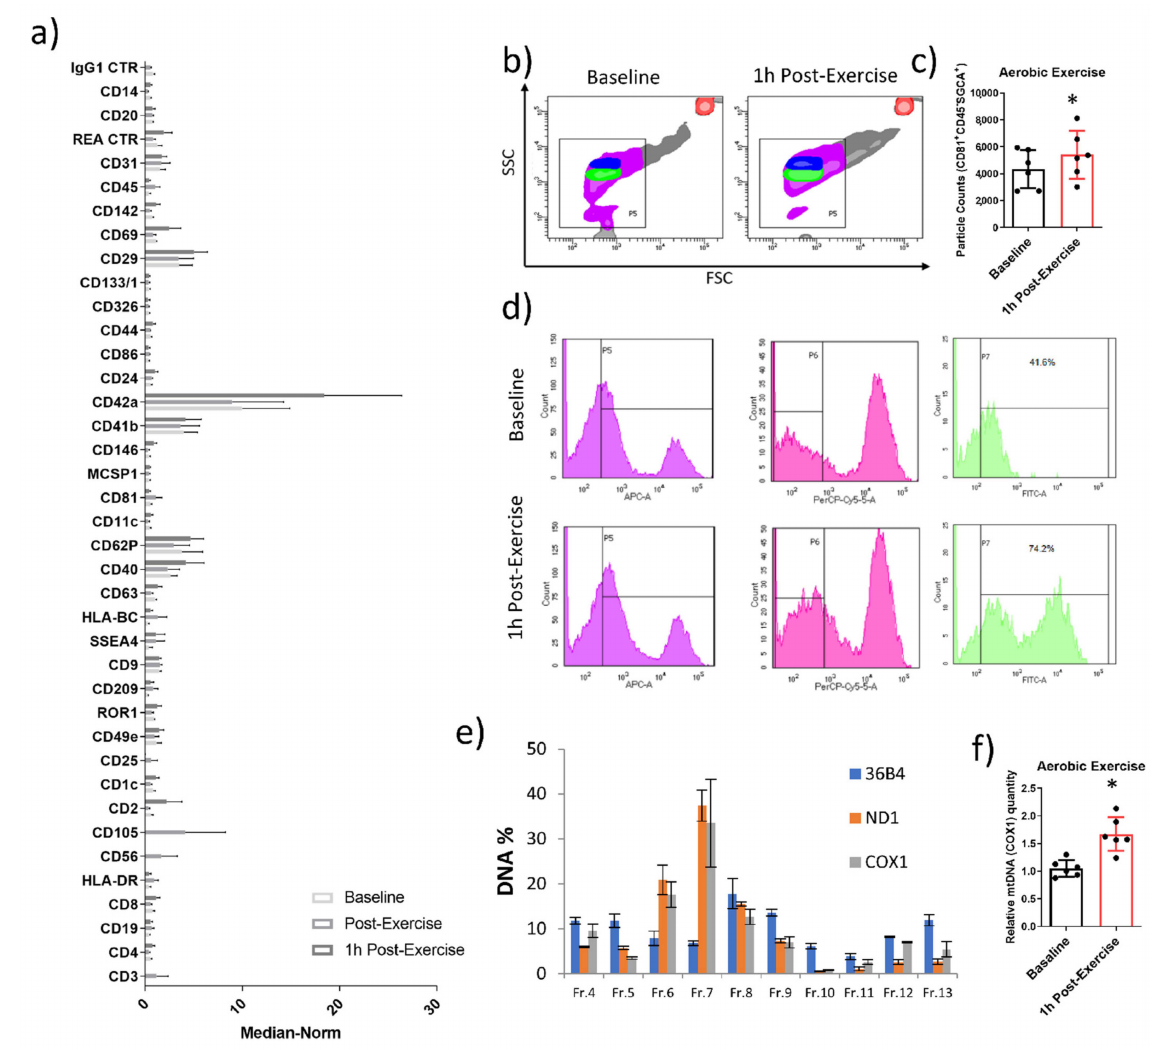
Figure 8. MACS plex analysis for each EV marker of circulating vesicles isolated by SEC (Fr. 7) at baseline and following aerobic exercise (immediately and 1 h after the end of exercise bout) ( a ). Contour plot FSC vs. SSC of EV preparations derived from baseline (left panel) and post-exercise (right panel) samples. Green and blue clusters represent the area of beads sized 500 nm and 1 micron, respectively. Such beads were acquired previously and dispersed in the filtered buffer in which each sample is prepared (see Supplementary Materials Figure S2). The red circle represents counting beads (DakoCyto-Count), whereas pink and violet events represent the EVs further characterised for CDs expression ( b ). Then, a protocol of gating strategy is applied in ( b ), both on the baseline and post-exercise samples: Violet events (histogram) are those from the area identified using size beads; Pink events (histogram) are those enclosed by P5, drawn in the violet histogram, virtually corresponding to appropriate-sized events, positive for CD81. This histogram focuses on CD45 expression. Green events (histogram) are those enclosed by P6, drawn in the pink histogram, virtually corresponding to appropriate-sized events, positive for CD81, and SGCA and negative for CD45 ( d ). The absolute counts of CD81 + /CD45 − /SGCA + EVs are reported in the subfigure ( c ). Real-time PCR quantification of mitochondrial ( ND1 and COX1 ) and nuclear ( 36B4 ) genes in SEC fractions ( e ) and in Fr. 7 obtained from plasma samples of baseline and 1 h post-exercise subjects ( f ). The results are represented as mean ± SE. * significant difference from baseline ( p <